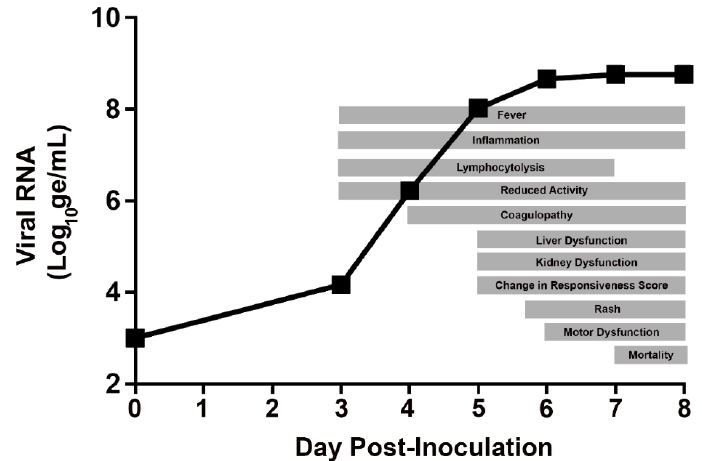
Figure 11. Schematic showing generalized progression of acute EVD following exposure to IM/EBOV in rhesus macaques. The day of EBOV exposure is designated Study Day 1.